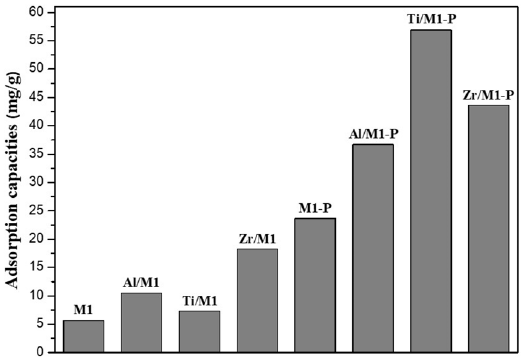
Figure 13. Adsorption capacities of all materials synthesized in this work.